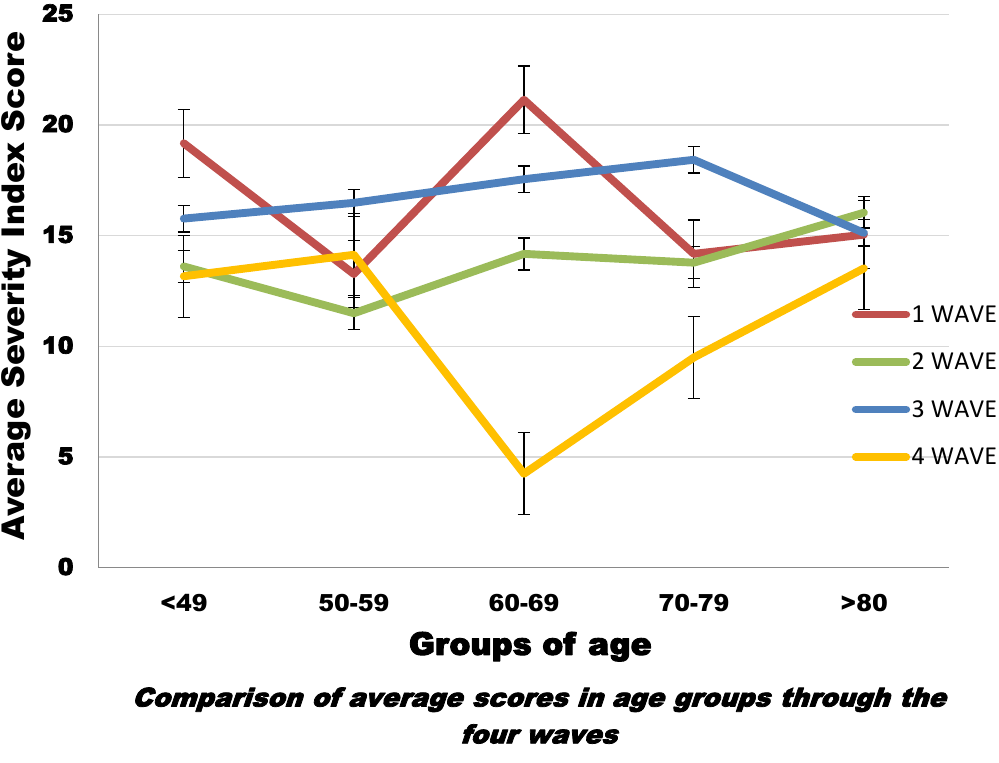
Figure 5. Graphic representation of mean CT scores in age groups through all waves of the disease.